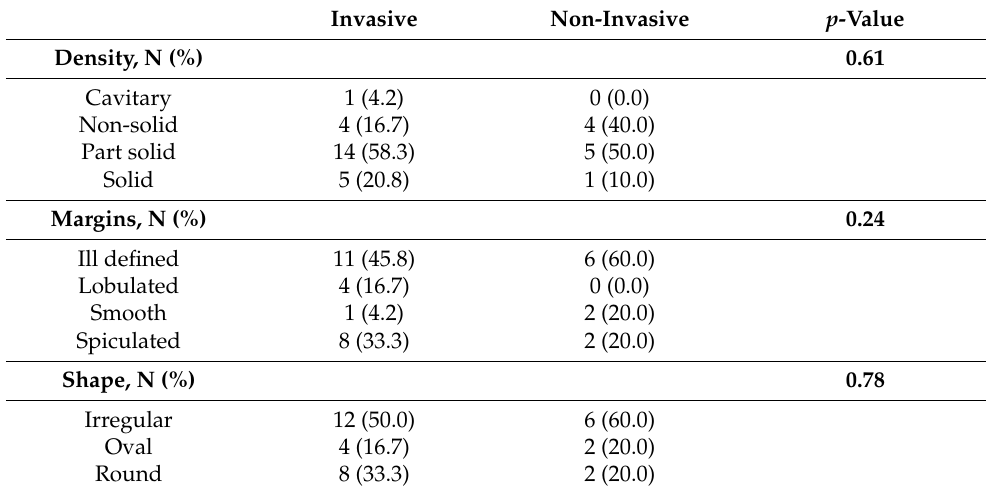
Table 3. Correlation of imaging with final pathology on explant lung.